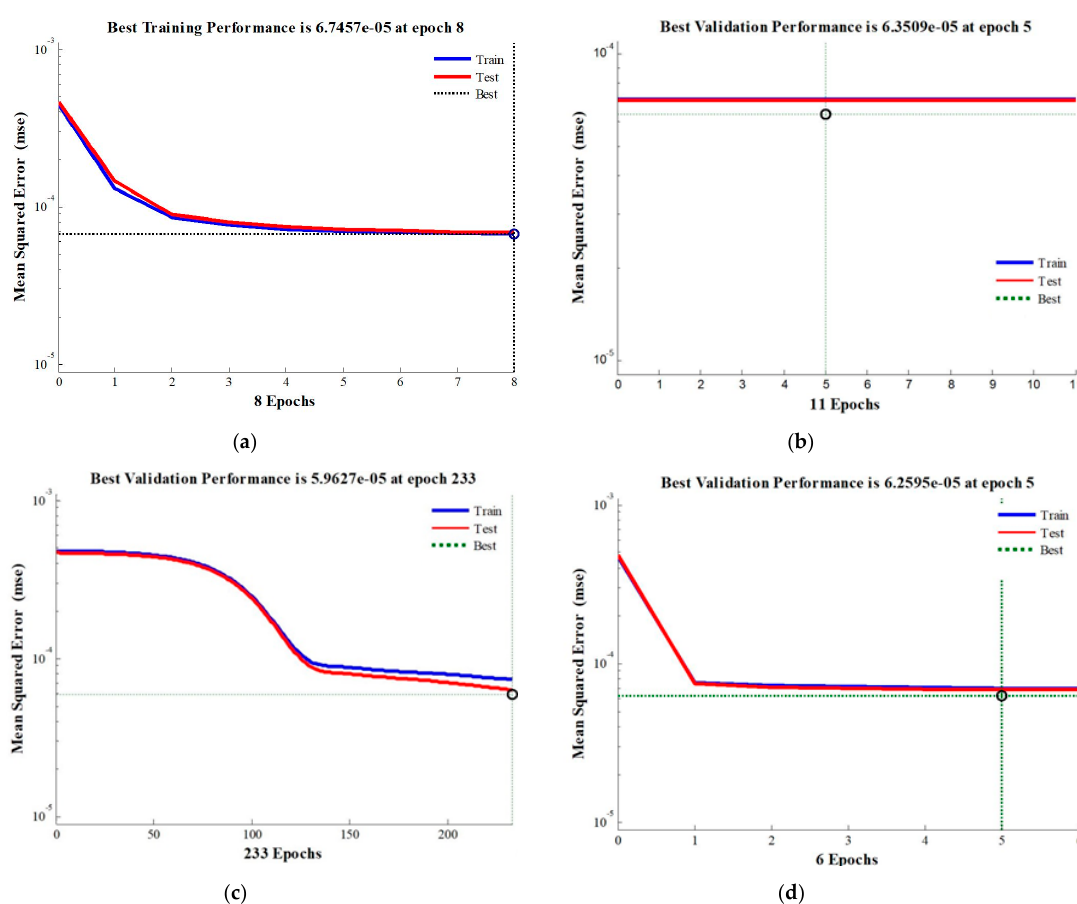
Figure 9. Mean square error diagram for feed-forward backdrop using ( a ) Bayesian Regulation, ( b ) Polak-Ribiere Restarts, ( c ) Gradient Descent with momentum and adaptive learning rate, and ( d ) Levenberg-Marquardt Algorithm.